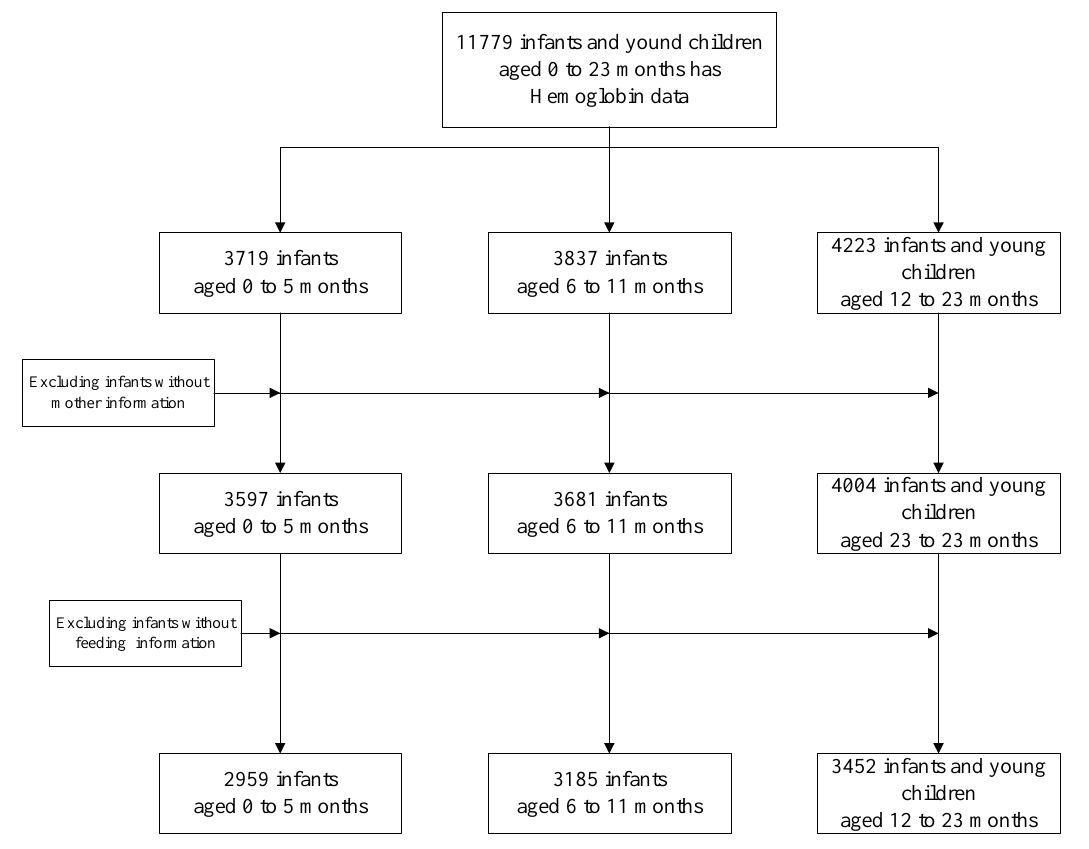
Figure 1. Flowchart of study procedures.